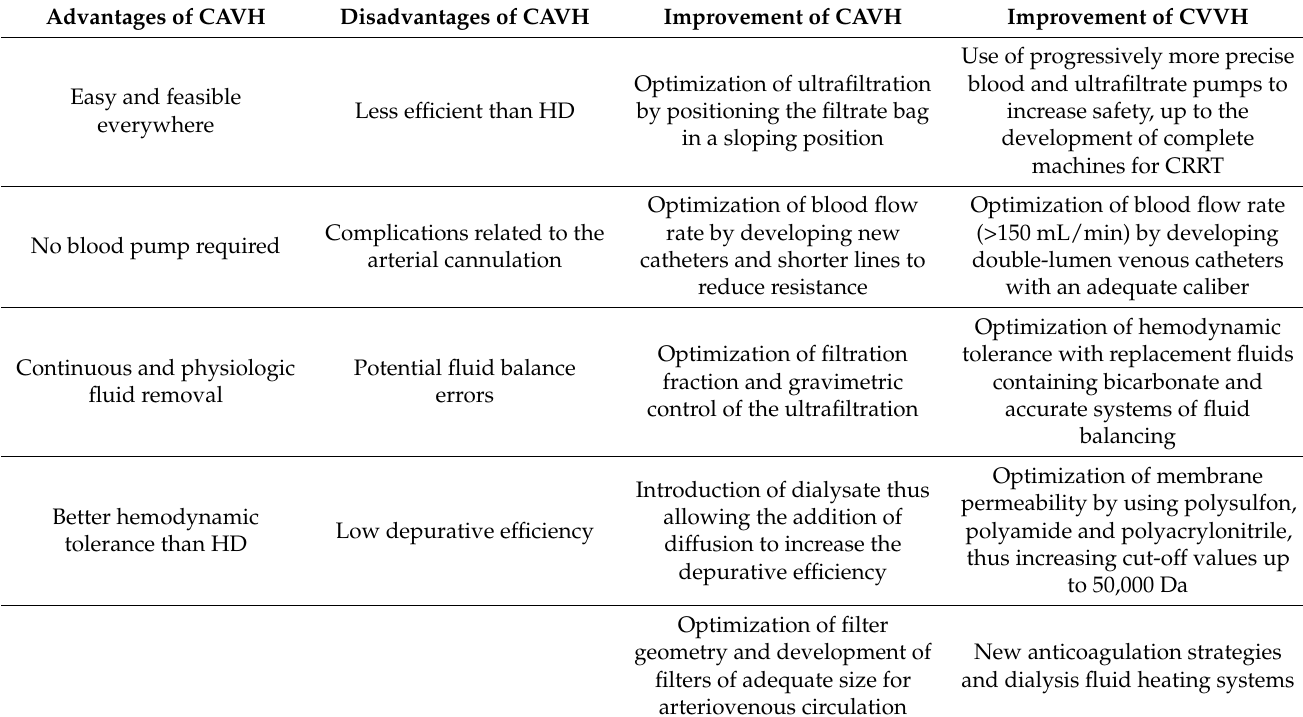
Table 1. Advantages and disadvantages of continuous arteriovenous hemofiltration (CAVH) and evolution to continuous veno-venous hemofiltration